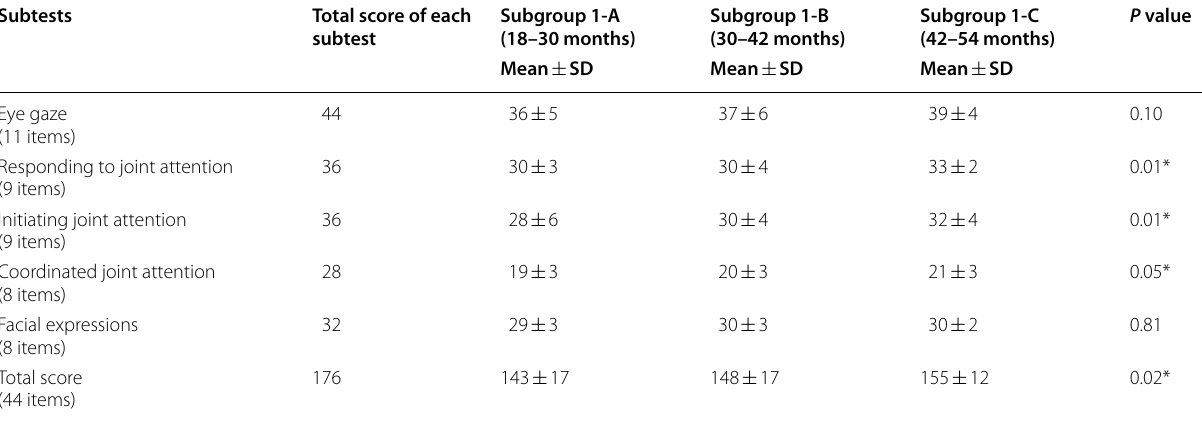
Data expressed as mean